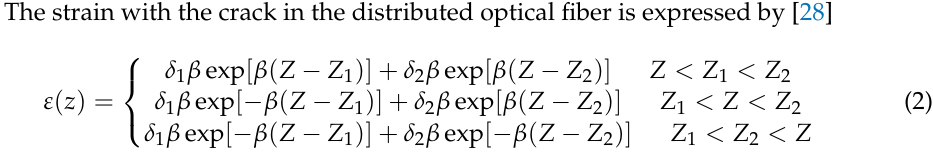
Figure 1. Distribution optical fiber sensor with two cracks.